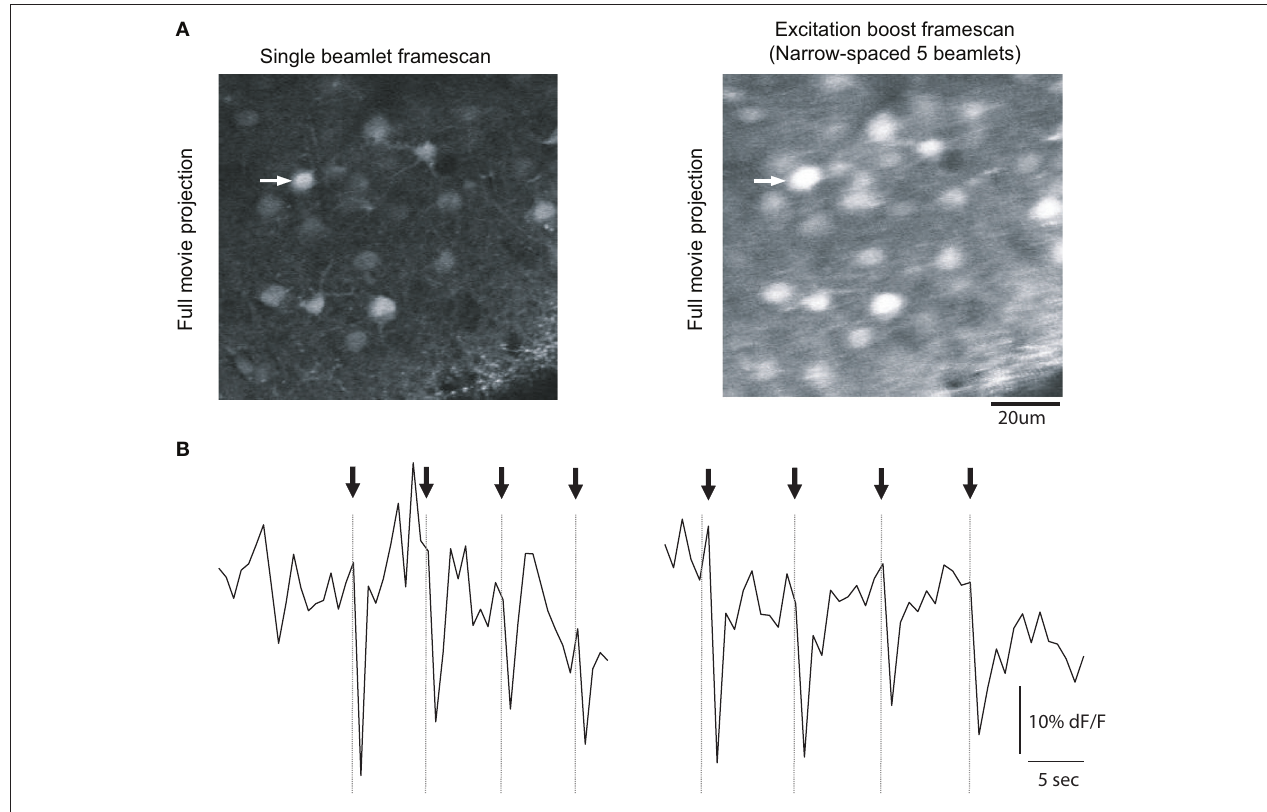
by arrow in (A) . Scales identical in left and right graphs, vertical axis in arbitrary brightness units, horizontal axis in seconds. The neuron of interest was patch clamped was driven to fi re sets of three action potentials during the optical recording and calcium transients are visible corresponding to times of action potential fi ring (indicated by arrows and vertical lines). Signal to noise ratio was improved by an average of 1.95 ± 0.72 fold in the excitation boost multibeam excitation boost frame scan mode relative to single beam